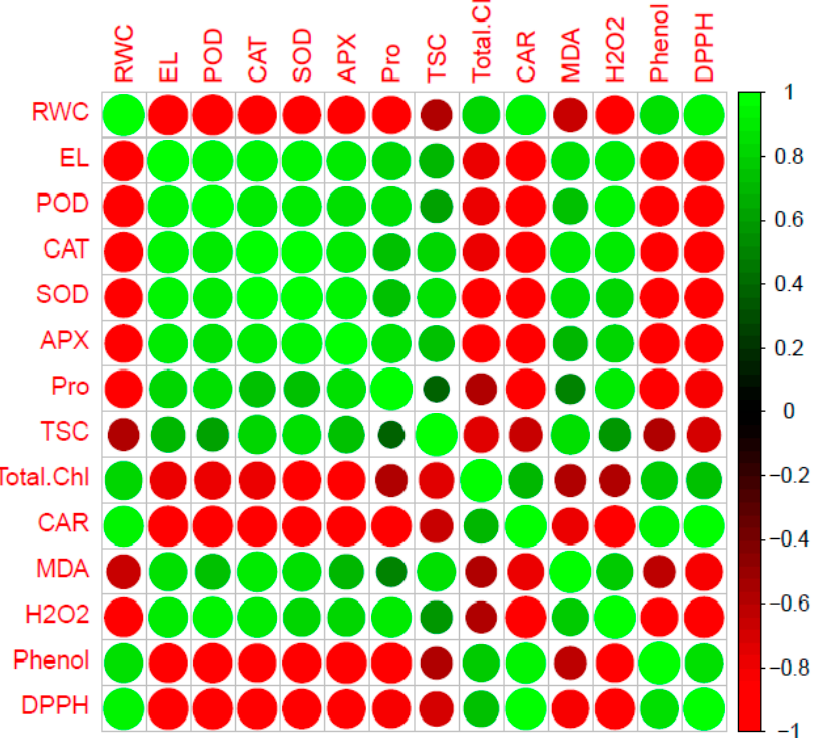
Figure 2. Heatmap of Pearson correlation coefficient of all evaluated traits in two strawberry cultivars (Camarosa and Gaviota) at four drought stress levels (100, 75, 50, and 25% FC). The right height axis exhibits positive and negative correlations presented in green and red colors, respectively, according to the color scale, RWC, relative water content; EL, electrolyte leakage; POD, peroxidase activity; CAT, catalase activity; SOD, superoxide dismutase activity; APX, ascorbate peroxidase activity; Pro, proline; TSC, total soluble carbohydrates; Total Chl, total chlorophyll; CAR, carotenoids; MDA, malondialdehyde; H 2 O 2 , hydrogen peroxidase; Phenol, total phenolic content; DPPH, antioxidant activity.